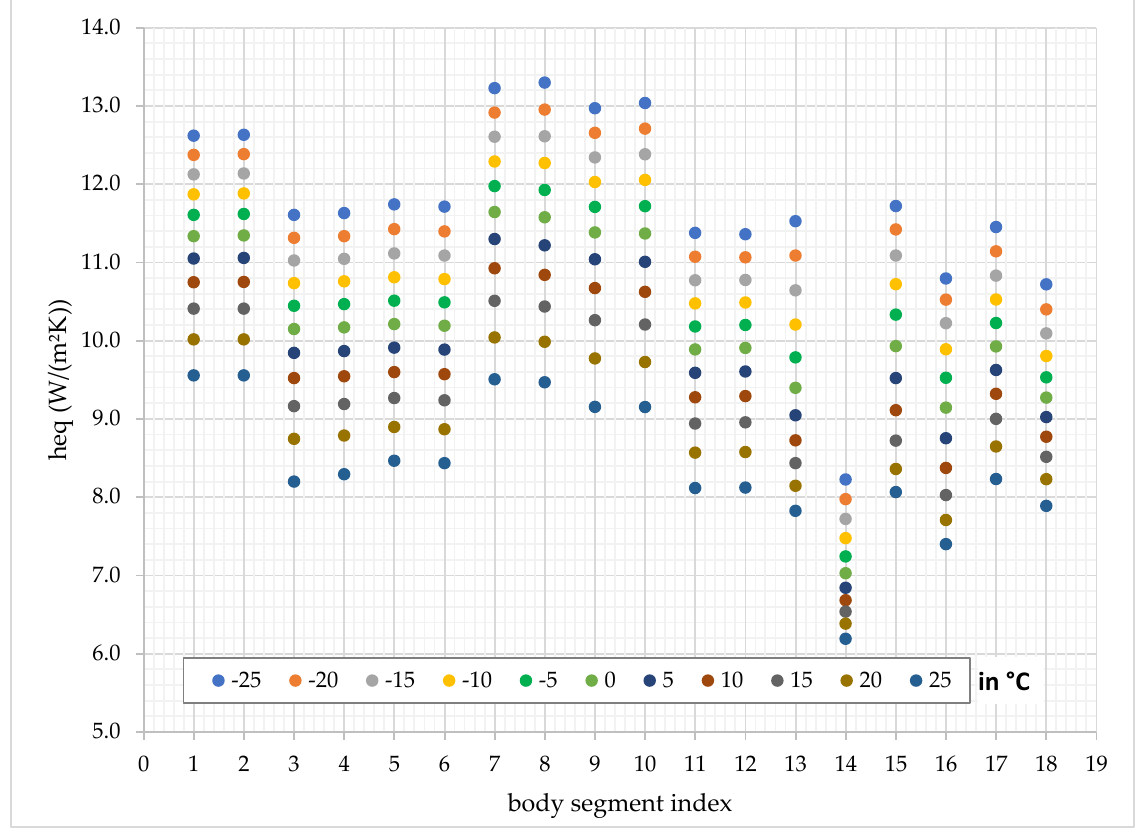
Figure 5. h eq for different equivalent